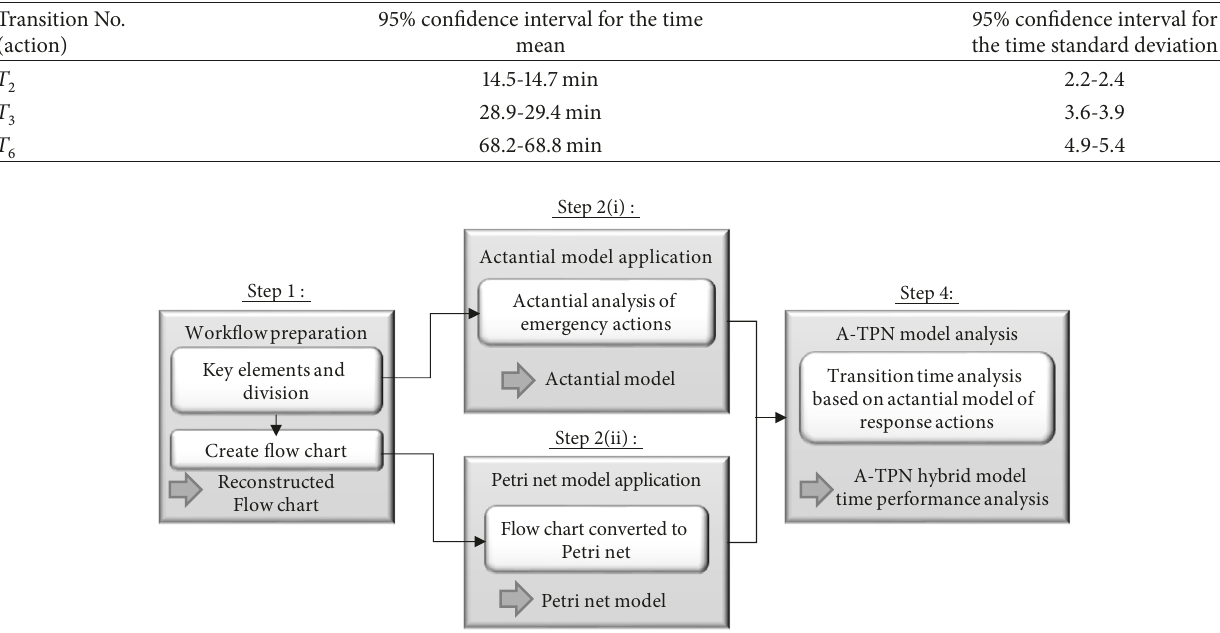
Table 5: Interval estimation at the 95% confidence level for the ending time of key actions.